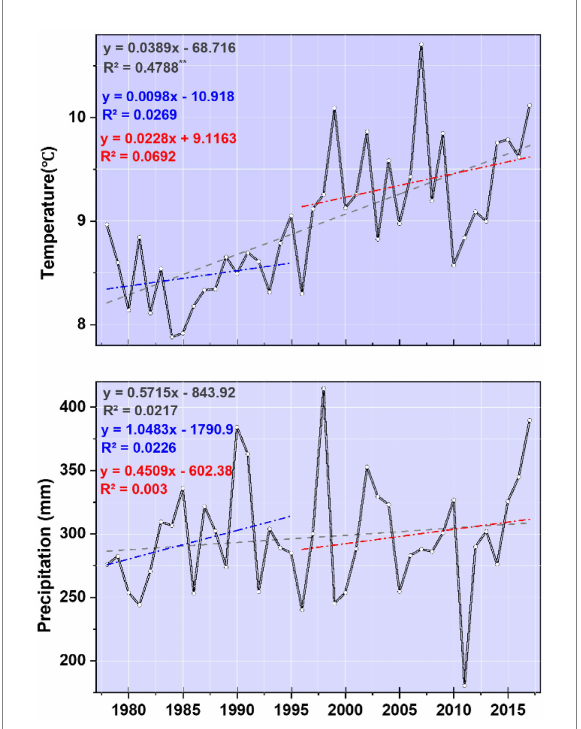
FIGURE 3 The climatic conditions during the winter wheat growing season in the main-producing regions in China from 1978 to